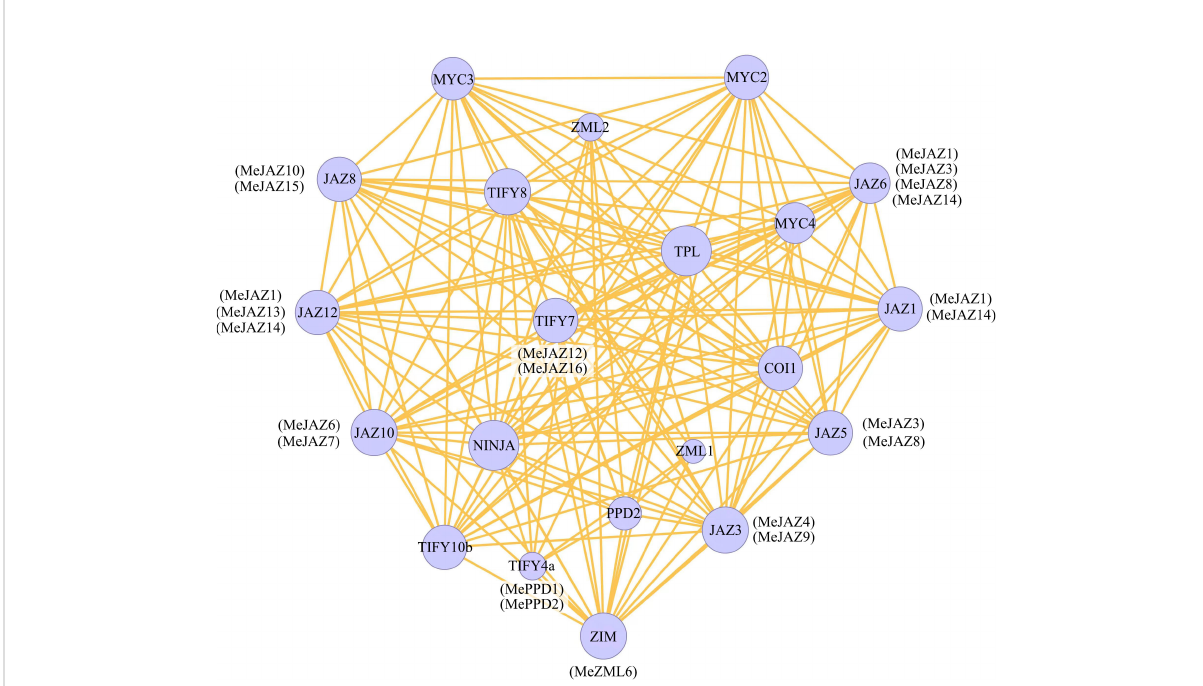
FIGURE 5 Protein – protein interaction network of cassava JAZ, PPD, and ZML proteins based on their orthologs in Arabidopsis. The color scales represent the relative signal intensity scores. Predicted functional partners exhibited in the network, including NINJA (NOVEL INTERACTOR OF JAZ), TPL (TOPLESS), COI1 (CORONATINE INSENSITIVE 1), and MYC